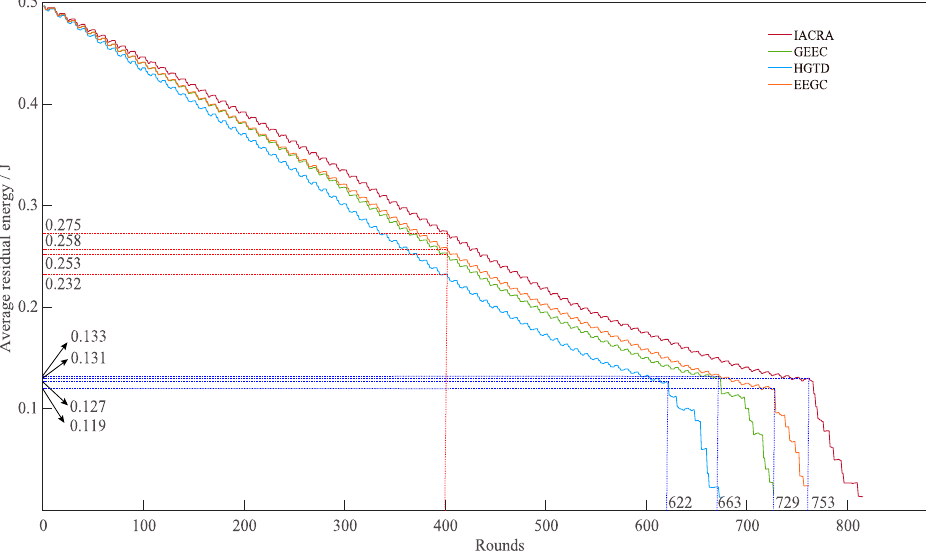
Figure 11. Comparisons of average residual energy of IACRA, GEEC, HGTD, and